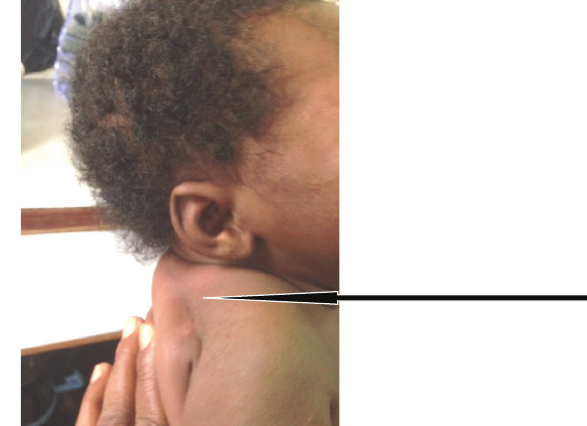
Figure 5: Residual hyperpigmented patch on the right thigh with small discrete swellings on the skin over anterior surface of the thighs noted at presentation to the emergency